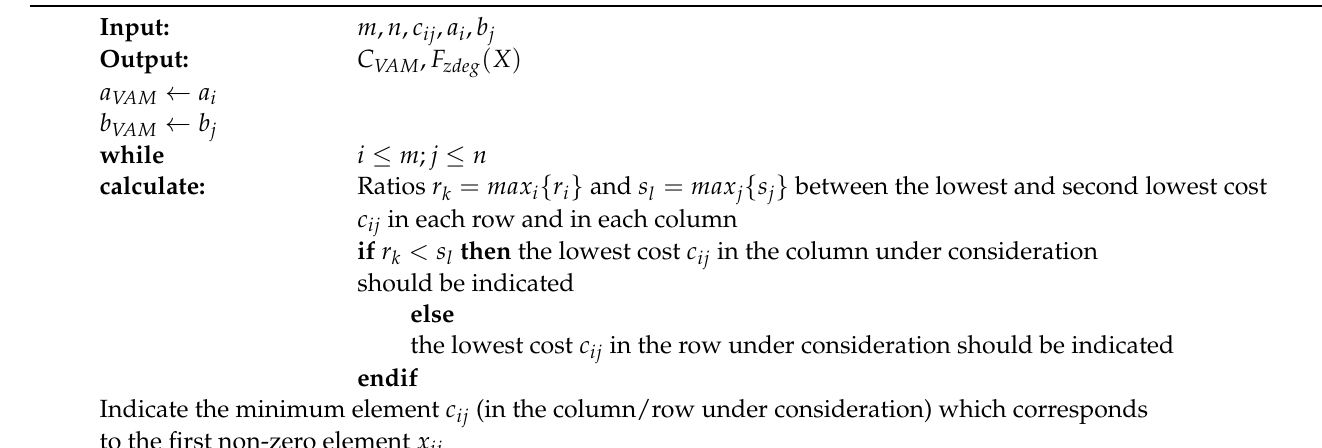
Algorithm 4 Pseudocode for the Vogel’s Approximation Method